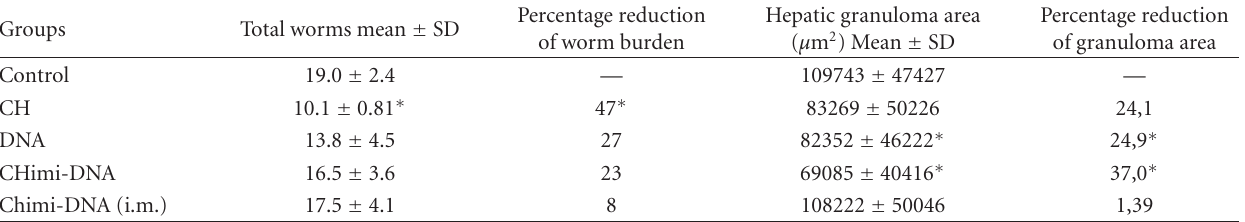
Table 1: Protective e ff ect and liver granuloma size induced by C57BL/6 mice vaccination with CH-DNA nanoparticles and challenged with 25 S. mansoni